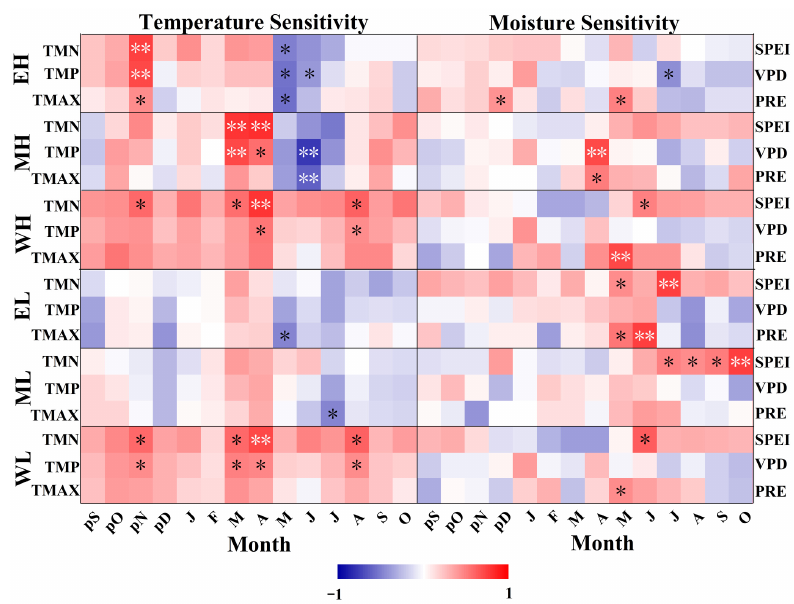
Figure 7. Correlations between EVI and climate factors from September of the previous year to October of the current year in the Qilian Mountain regions from 2000 to 2020 (P—previous year; TMN—mean minimum temperature; TMP—mean temperature; TMAX—mean maximum temper- ature; SPEI—standardized precipitation evapotranspiration index; VPD—vapor pressure deficit; PRE—precipitation). ** p < 0.01; * p < 0.05.